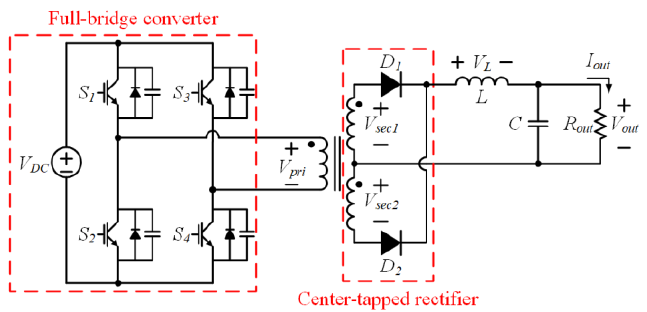
Figure 1. Circuit configuration of the PSFB-CT.